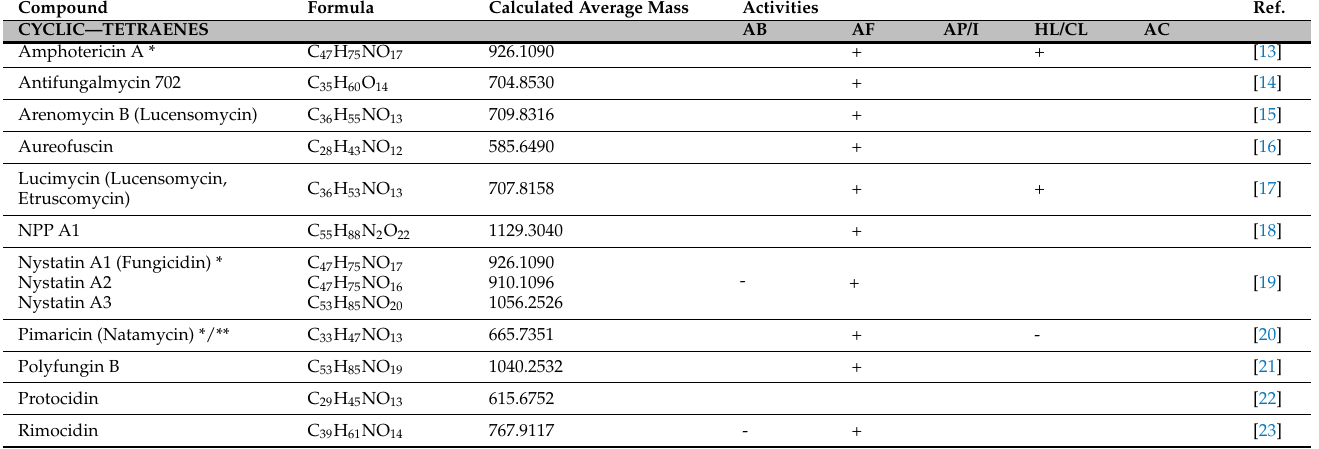
Table 1. Actinomycete polyene SMs. AB—antibacterial; AF—antifungal; AP/I—antiparasitic, insecti- cidal; HL/CL—hemo-/cytolytic; AC—anti-cancer. Asterisks indicate compounds with clinical (*) or agricultural (**)